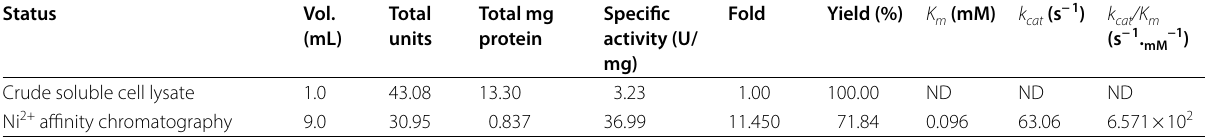
not a transmembrane protein, inferred from the analy- sis of its protein sequence through three online serv- ers: TMHMM2.0, SOSUI, and PHOBIUS. The predicted molecular mass and theoretical pI of AXE-HAS10 were 36.5 kDa and 5.67, respectively. Table 1 Purification table and kinetic parameters for hydrolysis of p -NP-C2 by recombinant AXE-HAS10 Status Vol. (mL)